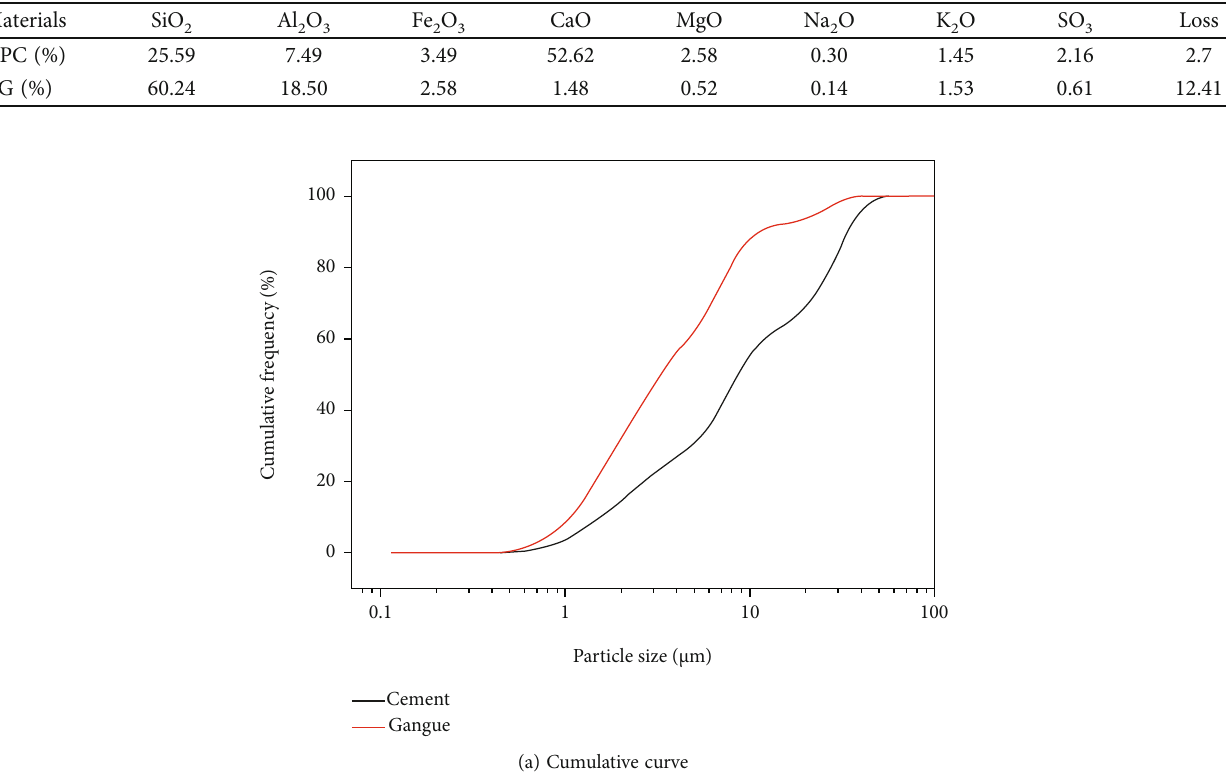
Table 1: Chemical composition of raw materials/(wt%).